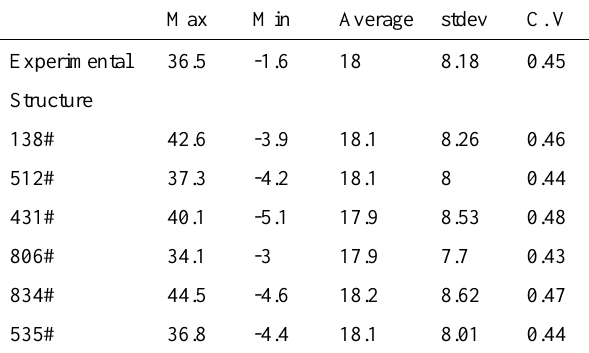
Table 4 Summary of temperature in and outside the Experimental Structure